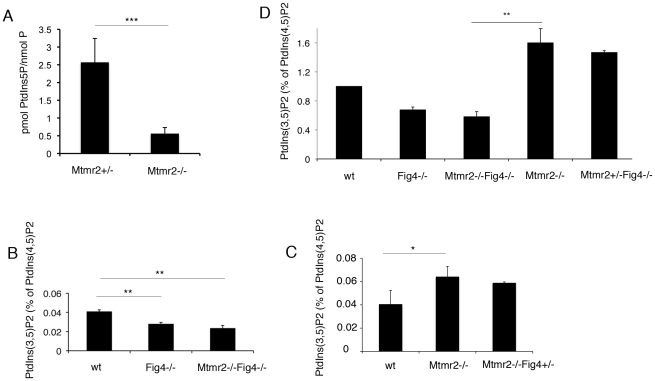
PI measurements from primary fibroblasts and Schwann cell/DRG co-cultures.(A) PtdIns5P was measured by in vitro mass assay in DRG co-cultures from Mtmr2+/− or Mtmr2−/− knock-out mice as described in Materials and Methods. Data are expressed as mean ± s.e.m. (n = 3 pools of at least 6 different explants per genotype). *P<0,05. (B–D) Fibroblasts from wild-type, Mtmr2+/+Fig4−/−, Mtmr2−/−Fig4+/+, Mtmr2−/−Fig4−/−, and Mtmr2−/−Fig4+/− mice were labeled for 16 h with [32P]orthophosphate. Lipids were extracted, deacylated and analyzed by HPLC. PtdIns(3,5)P
2 is expressed as percent of PtdIns(4,5)P
2. Data are expressed as mean ± s.e.m. (n = 3). No differences in PtdIns3P levels were demonstrated between the different genotypes analyzed (not shown). (B) PtdIns(3,5)P
2 levels were significantly reduced in Mtmr2+/+Fig4−/− cells as compared to wild-type, thus also confirming previous findings [20], whereas Mtmr2+/+Fig4−/− and Mtmr2−/−Fig4−/− cells showed similar levels of this lipid (P = 0.0071 between wild-type and Fig4−/−; P = 0.0044, between wild-type and double null cells). (C) Loss of Mtmr2 in Mtmr2−/−Fig4+/+ cells provoked a significant increase of PtdIns(3,5)P
2 (P = 0.0096), whereas no differences were detected between Mtmr2−/−Fig4+/+ and Mtmr2−/−Fig4+/− cells, possibly because heterozygous deletion of Fig4 leads to small PI changes hardly detectable using this method. (D) Comparison between the two independent experiments showed in (B) and (C), where each value was proportioned to the wild-type belonging to the same experiment and wild-type values were arbitrarily converted to 1 (P = 0.0055 when comparing Mtmr2−/−Fig4−/− and Mtmr2−/−Fig4+/+ cells).